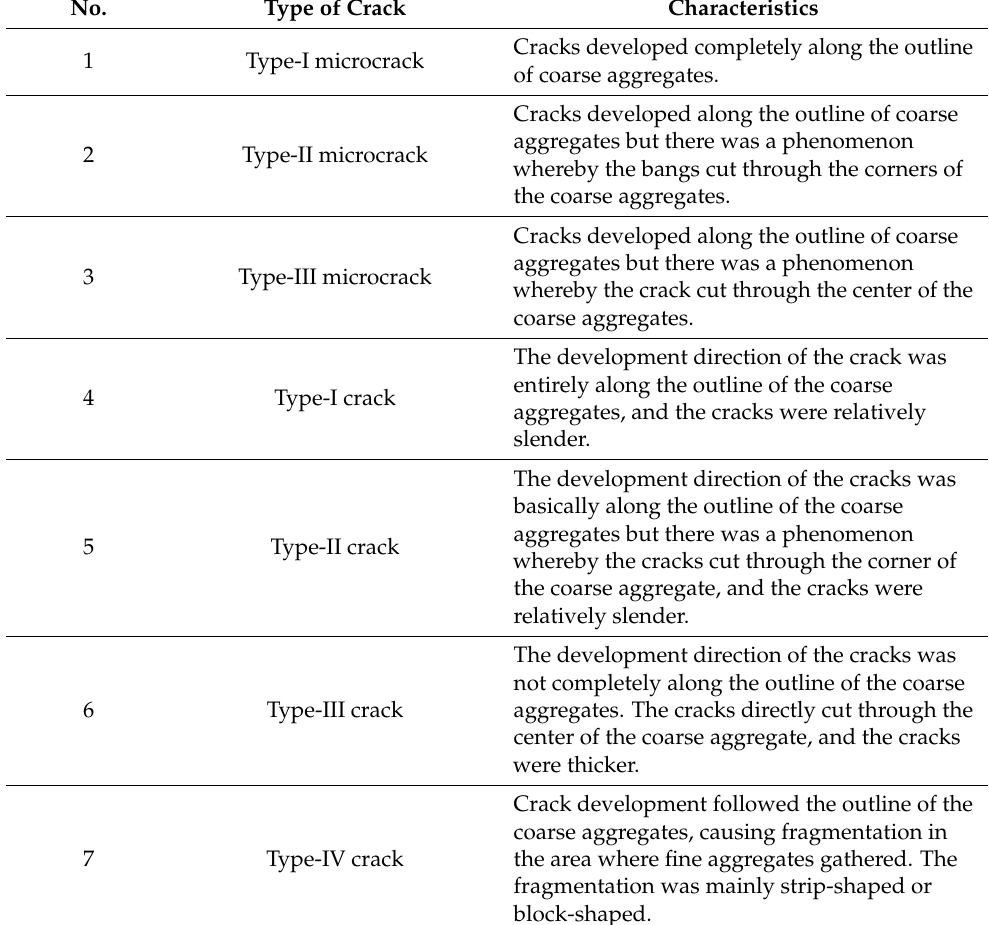
Table 2. Crack classification [126]. Table 2. Crack classi fi cation [126]. Table 2. Crack classi fi cation [126]. Table 2. Crack classi fi cation [126]. Table 2. Crack classi fi cation [126]. Table 2. Crack classi fi cation [126]. Table 2. Crack classi fi cation [126]. Table 2. Crack classi fi cation [126].